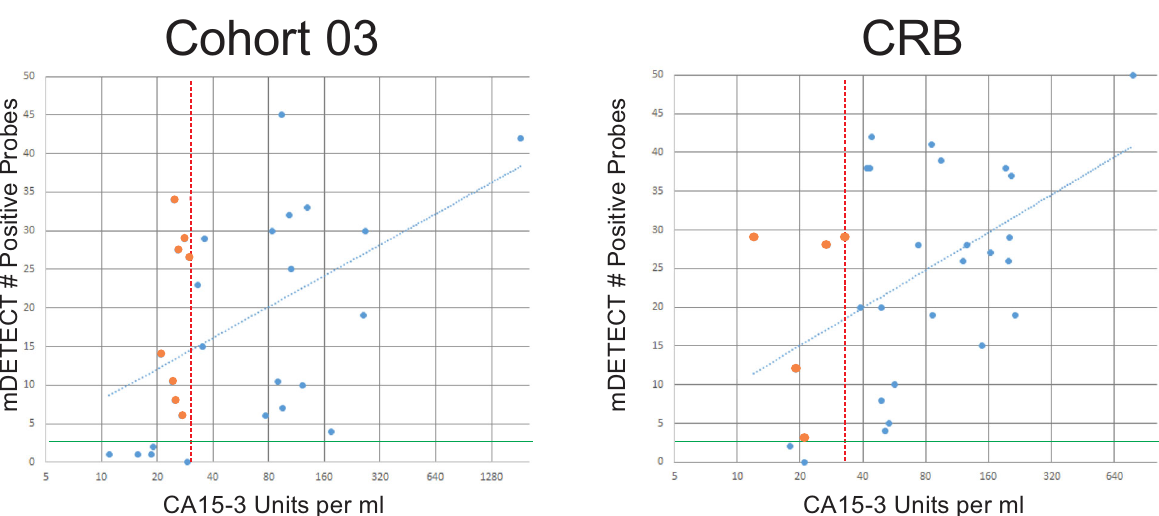
Fig. 10 Comparison of mDETECT and CA15-3 detection. The levels of mDETECT and CA15-3 were compared for patients in both Cohort 03 and CRB. The normal range of CA15-3 is up to 30 units per ml (red-dashed line) while the threshold for mDETECT is 2.5 positive probes (Solid green line). In the Cohort 03, eight patients that were negative for CA15-3 were positive as determined by mDETECT (orange circles). Similarly, fi ve patients in the CRB cohort that were negative by CA15-3 were positive by mDETECT (orange circles). The mDETECT and CA15-3 levels were somewhat correlated with an R 2 -value of 0.225 for Cohort 03 and 0.238 for the CRB cohort (blue dashed